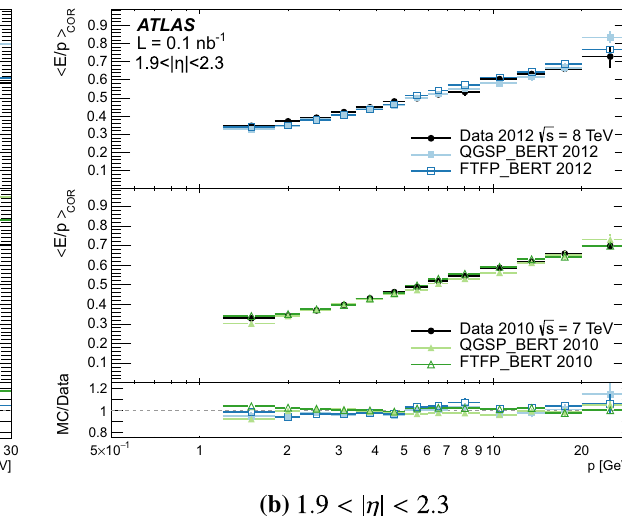
cant pile-up are shown together with MC simulations employing two different hadronic shower